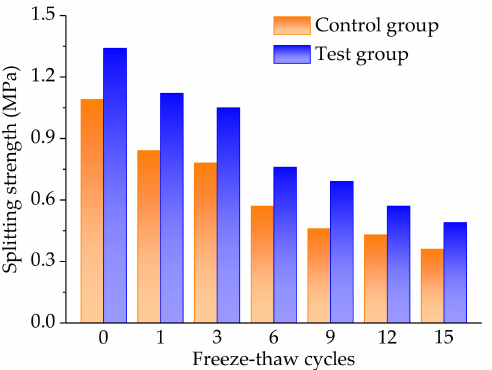
Figure 12. Comparative results of the splitting strength of the control and the test groups, under different freeze-thaw cycles.